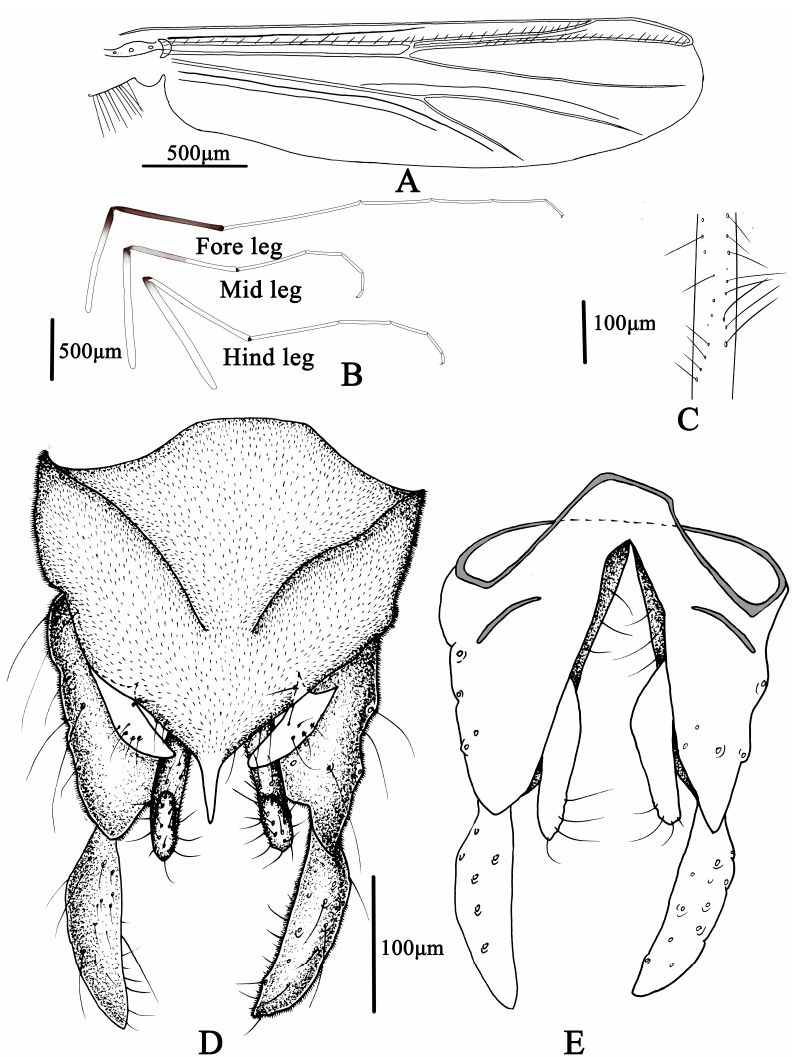
Figure 9. Male adult of Microtendipes nigrithorax sp. nov.: ( A ) wing; ( B ) legs; ( C ) directed setae in front femur; ( D ) hypopygium in dorsal view; ( E ) hypopygium in ventral view. Type material . Holotype: male (Sample ID & Field ID: CH412), China, Sichuan Province, Dujiangyan County, Qingchen Mountain, N 30.9188, E 103.4948, 28 July 2015, leg. B.J. SUN, light trap. Paratypes: five males, the same data as holotype.